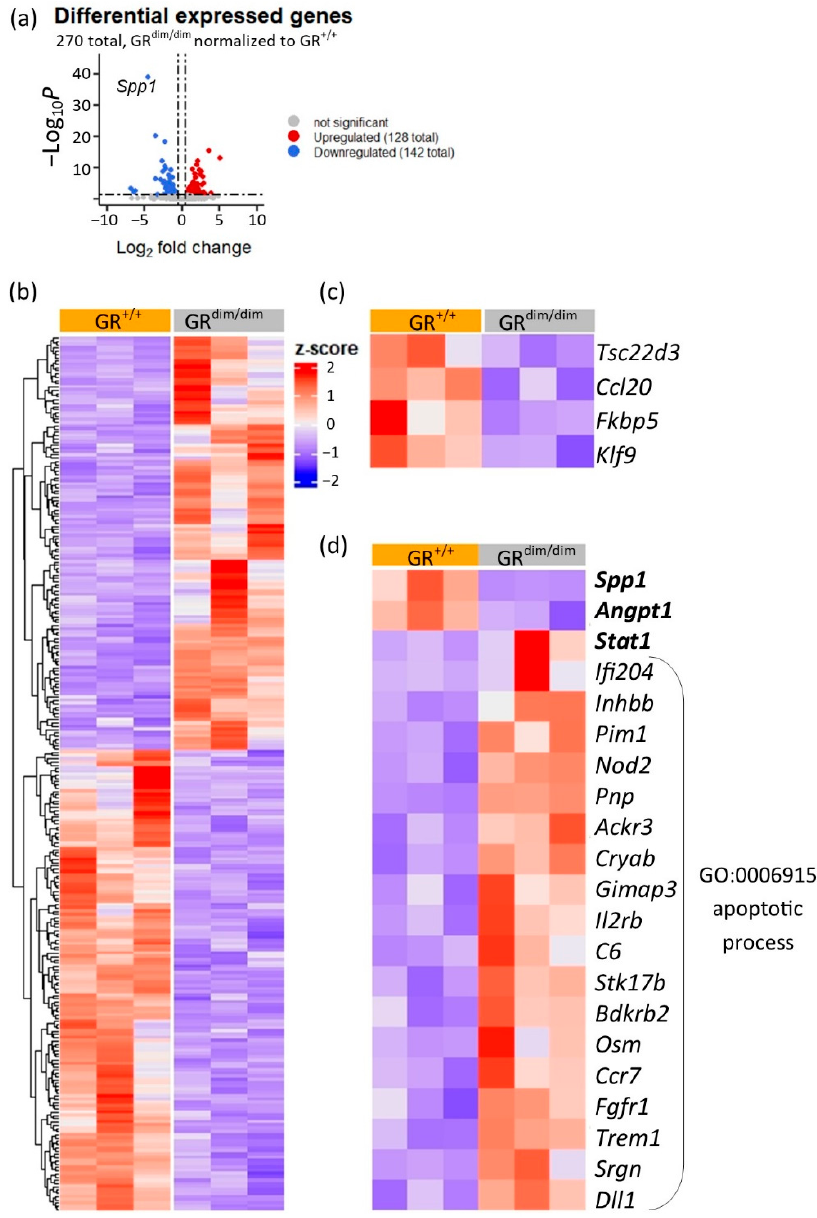
Figure 2. Bulk RNA-sequencing of lung samples from GR dim/dim and GR +/+ mice after HS with subsequent resuscitation. ( a ) Up- and downregulated DEGs (thresholds: p -adjusted value < 0.05, fold change > 0.5) plotted by p -value ( − Log 10 P ) and fold change (Log 2 fold change). ( b ) DEGs with a FDR < 0.05 z-score sorted for up- and downregulation relative to the expression level in GR +/+ lung tissue. ( c ) Heatmap of selected GR target genes showing impaired expression of GR target genes in lung tissue from GR dim/dim mice. ( d ) Relative expression of Spp1 , Angpt1 , Stat1 and genes upregulated in GR dim/dim annotated with GO term “apoptotic